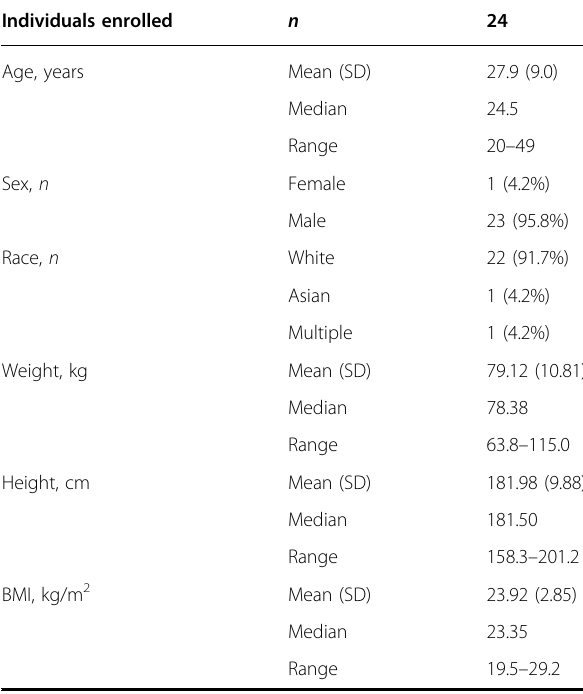
Table 1. TAK-653 plasma levels at 30 min and 2.5 h